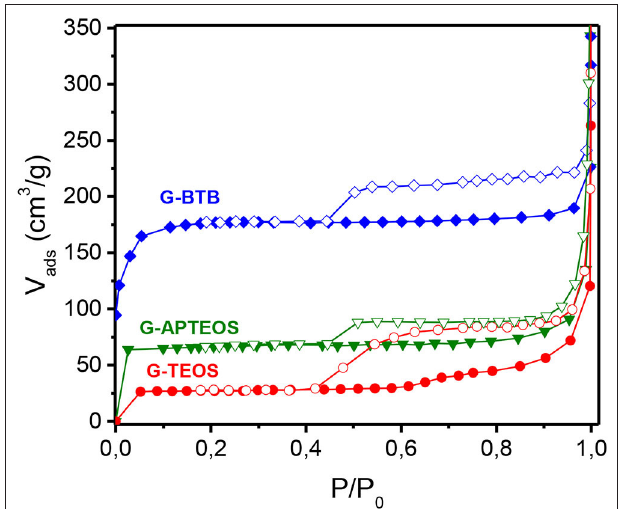
FIGURE 6 | N 2 adsorption (full symbols)-desorption (empty symbols) isotherms at 77K of heterostructures prepared by silylation of organo-modified graphene oxide with either 1,4-Bis(triethoxysilyl)-benzene, or with (3-aminopropyl)triethoxysilane, or with tetraethylorthosilicate, and calcinated to give G-BTB, G-APTEOS and